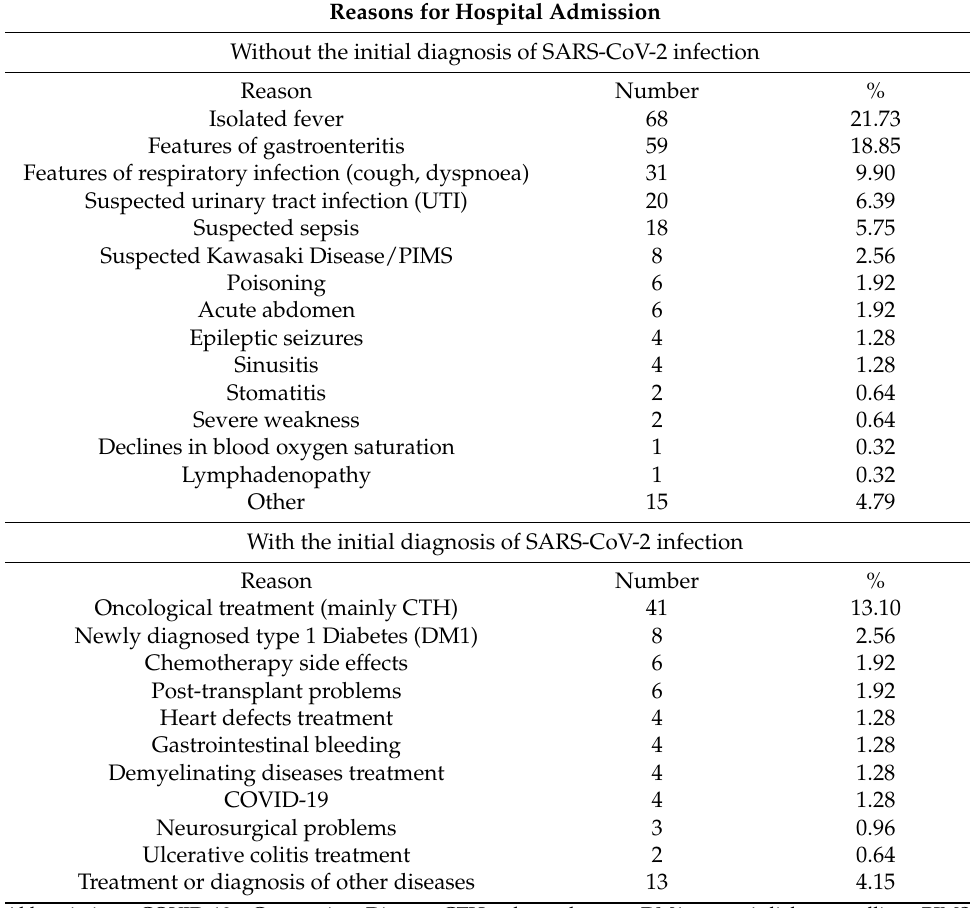
Table 1. Reasons for hospital